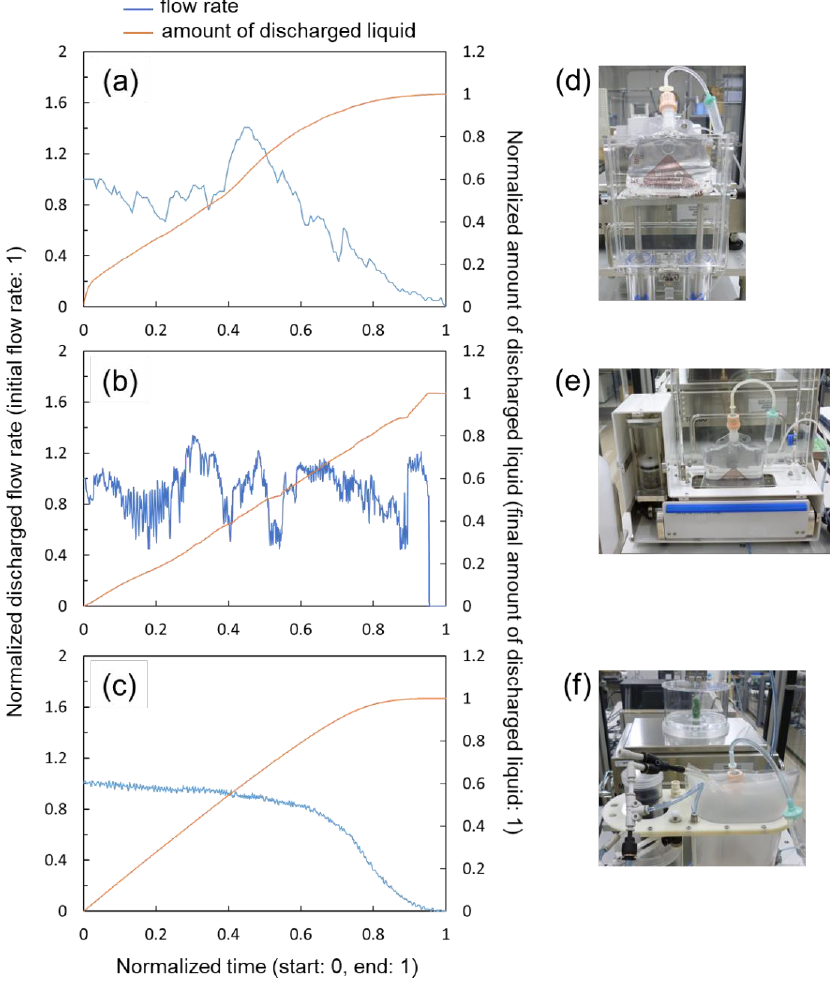
Figure 10. Flow rate measurement results of the prototypes. ( a ) Prototype UP-PRESS. ( b ) Prototype FIX-ROLLER. ( c ) Prototype AIR-BAG. ( d – f ) Pictures of prototypes under tests corresponding to ( a – c ).